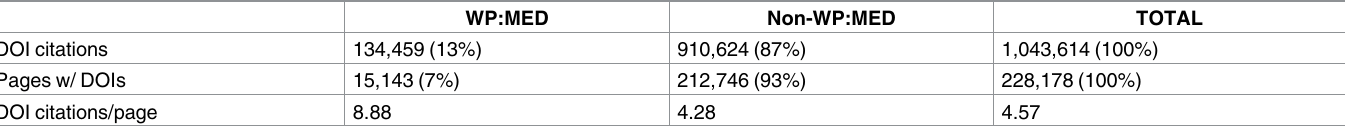
Table 3. Averagenumber of DOI citations and averagenumber of pages with DOIs for WP:MED and non-WP:MED for August 2016.